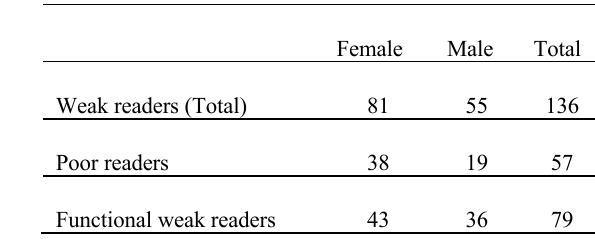
Table 2: Media descriptions of audio-visual